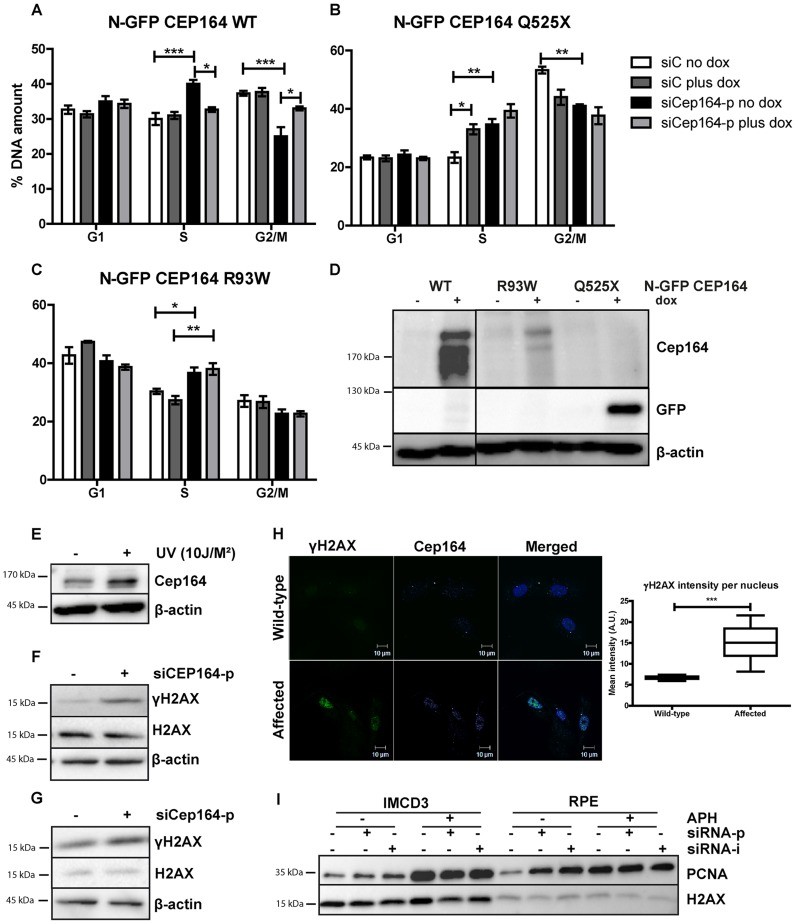
Knockdown of Cep164 causes S-phase delay.(A–D) Endogenous Cep164 knockdown leads to block in S-phase and is rescued by inducible human wild type CEP164 but not by human mutant CEP164. Under thymidine synchronization, Cep164 knockdown cells (black) were lagging in the transition from S to G2/M phase in comparison to the control siRNA treated cells (white) in all IMCD3 N-GFP-CEP164-WT (A) IMCD3 N-GFP-CEP164-Q525X (B) and IMCD3 N-GFP-CEP164-R93W (C) cell lines. Upon doxycycline induction of wild type human CEP164 construct IMCD3 N-GFP-CEP164-WT (light grey) cells were rescued from arrest in S-phase (A). In contrast, overexpression of the cDNA clone that represents the human truncating mutant N-GFP-CEP164-Q525X cells did not rescue the S-phase lag. In addition, overexpression of N-GFP-CEP164-Q525X (dark grey) caused an increase of cells in S-phase, indicating a dominant negative effect of the human truncating mutant (B). Cells were not rescued by N-GFP-CEP164-R93W (C) from the S-phase lag upon doxycycline induction. P values were calculated using two-way ANOVA and Bonferroni multiple comparison test. (n = 3, *p<0.05). (D) Western blot showing expression of N-GFP CEP164 WT and R93W by CEP164 antibody and N-GFP CEP164 Q525X by GFP antibody upon doxycycline induction. β-actin is used as loading control. (E) Lysates of IMCD3 cells were made 1 hour after 10J UV exposure. Western blot was performed for Cep164 and loading control β-actin. Stabilization of Cep164 is visible after DNA damage induction (n = 3). (F) Lysates of RPE cells were made 56 hours after knockdown of CEP164 with 20 nM siRNA. Upregulation of DNA damage marker γH2AX is shown on western blot with loading controls H2AX and β-actin (n = 3). (G) Lysates of thymidine synchronized IMCD3 cells were made 56 hours after knockdown of Cep164 with 20 nM siRNA. Upregulation of DNA damage marker γH2AX is shown on western blot with loading control H2AX and β-actin 6 hours after release of the thymidine block (n = 3). (H) Urine derived renal cells stained for γH2AX (green) and CEP164 (magenta) of NPHP patient and unaffected control. γH2AX intensities were quantified by ZEN2011 software. T-test reveals statistical difference (***p<0.001) (n = 15). (I) S-phase marker PCNA expression is increased in RPE and IMCD3 cells transfected with siCep164/CEP164p and –i compared to control transfected cells. β-actin was used as loading control. APH exposure (18 hour, 400 nM) enhanced the PCNA expression levels in both cell lines.